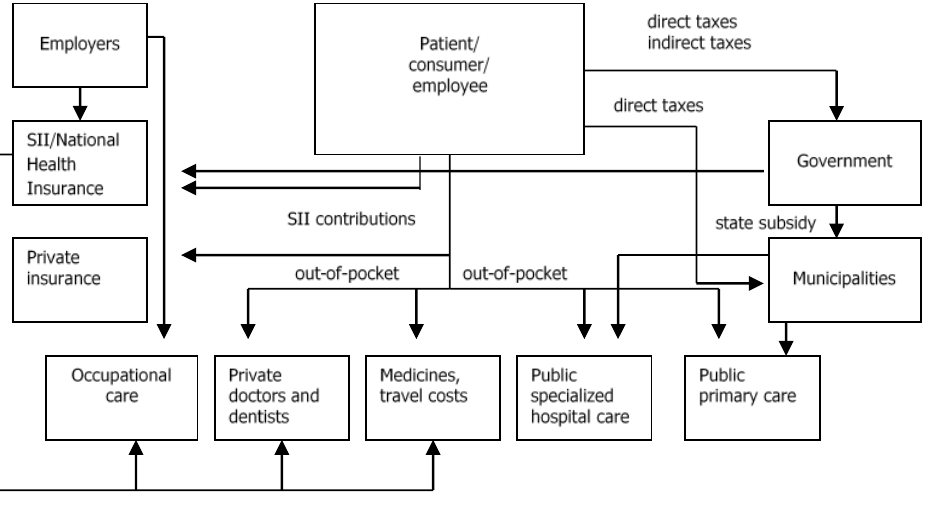
Monetary flows of the Finnish health care